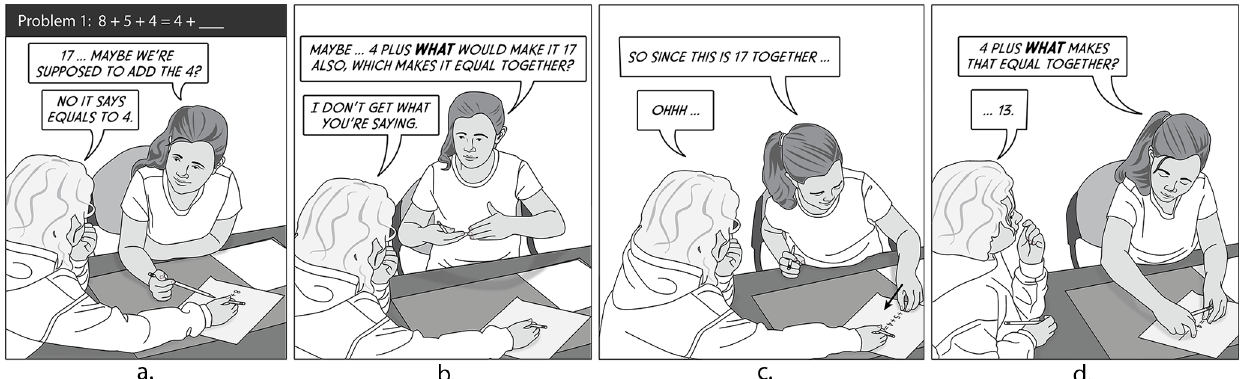
Figure 3. Synoptic Comic Strip of Jenny (Left) and Marie (Right) Working on Problem 1. From Alibali, Gutiérrez, & Brown (2017), under a CC-BY4.0